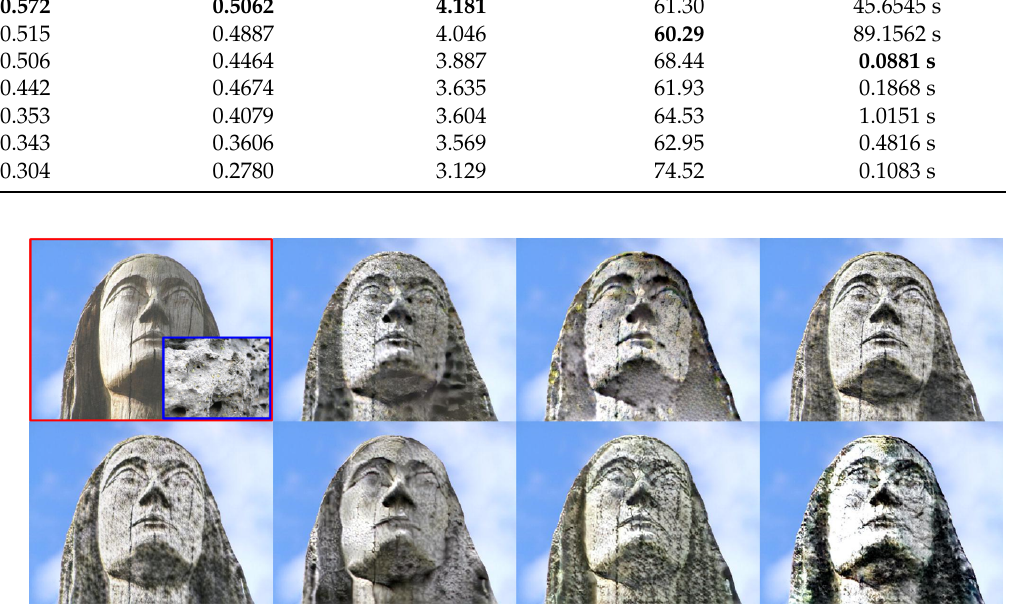
Figure 10. Qualitative results from all evaluated NST methods, translating from wood to stone. From left to right and top to bottom: content image (red) and style (blue); results from Gatys, STROTSS, Johnson, MetaStyle, WCT, LST, and